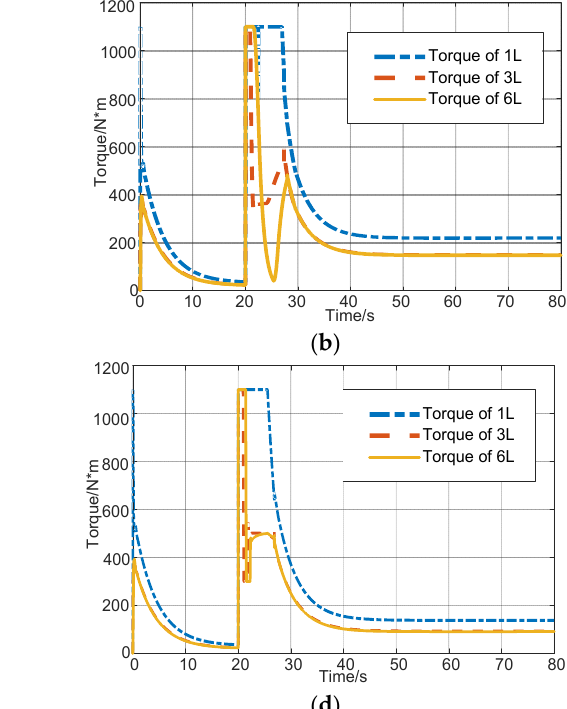
Figure 5. Vehicle speed on the changed road surface controlled by PID/SMC and HLQR.